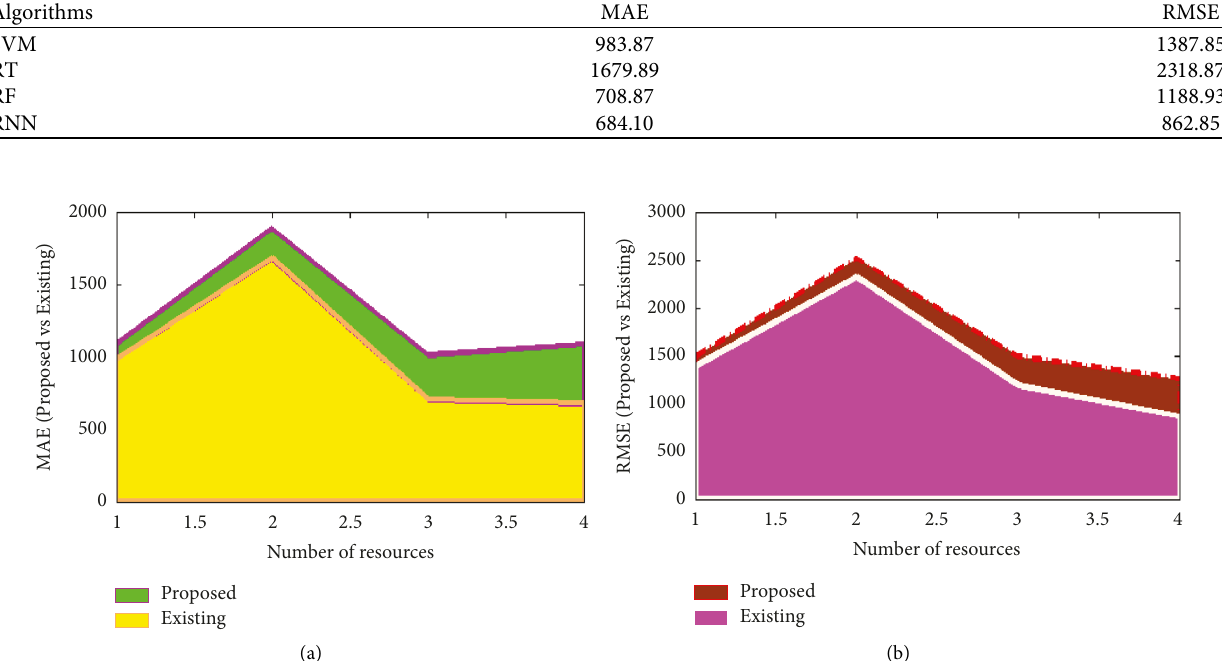
Figure 11: Comparison plot for the selected algorithms. (a) MAE. (b) RMSE.